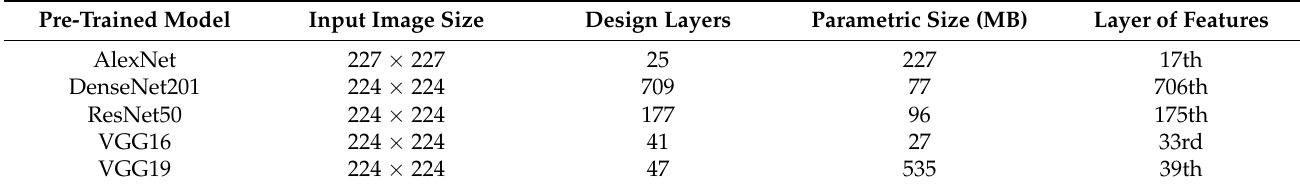
Table 2. Pre-trained models used in this study